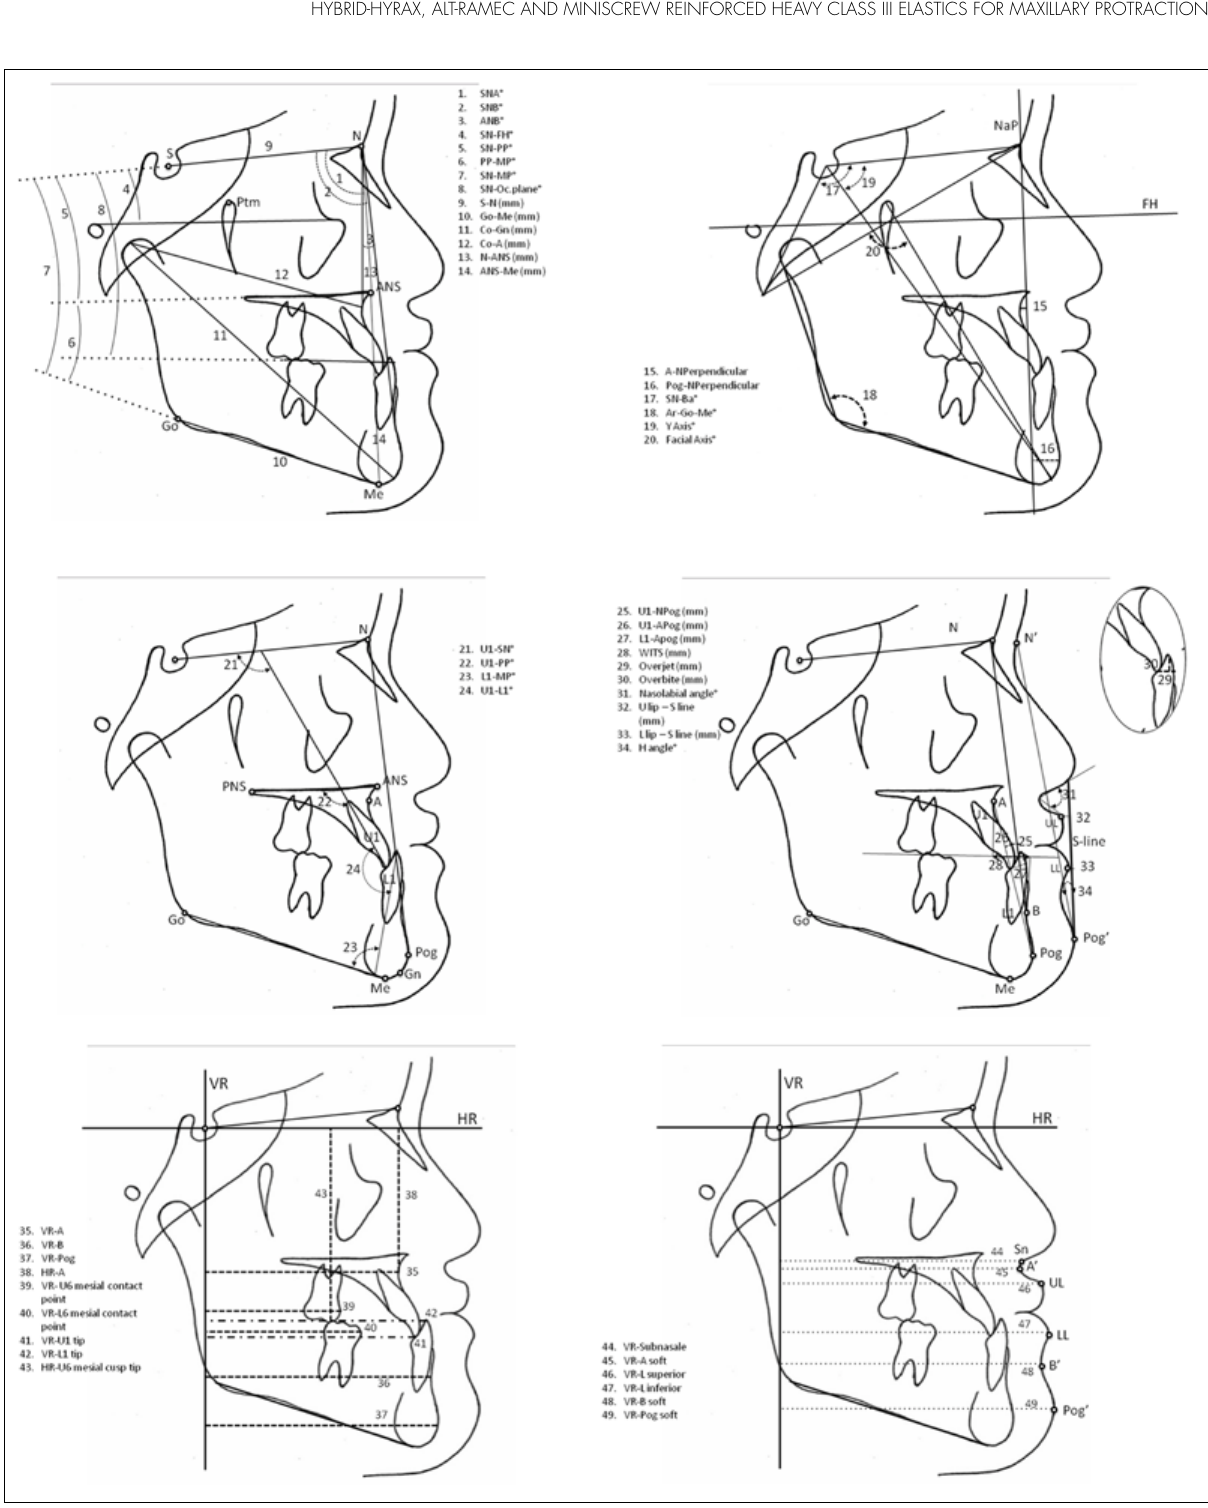
Figure 2. Skeletal, dental and soft tissue variables. Linear and angular cephalometric